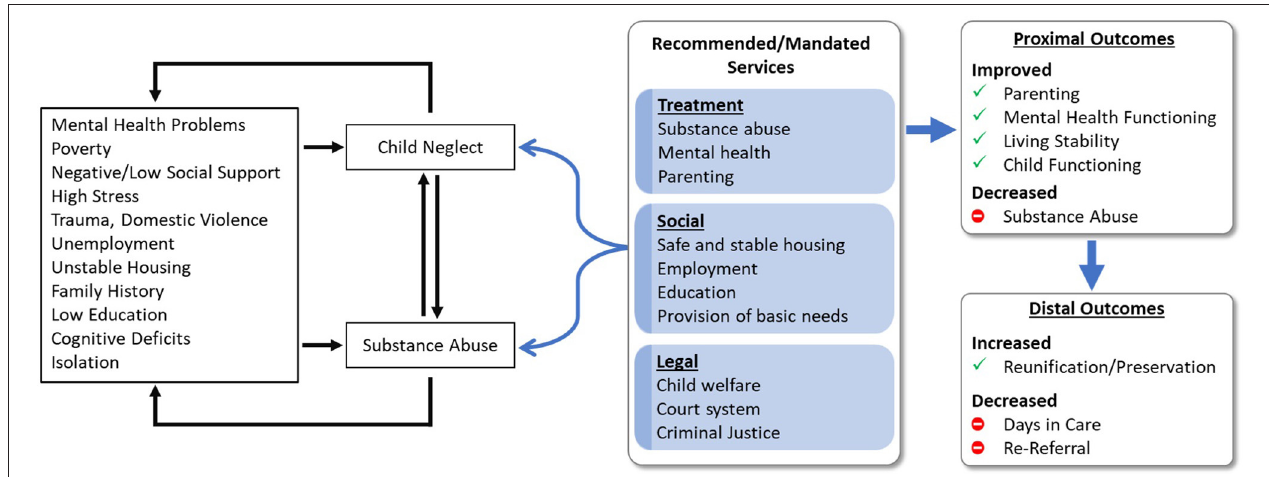
FIGURE 1 | Logic model for the Families Actively Improving Relationships (FAIR) program for parents involved in the child welfare system for parental substance abuse and child